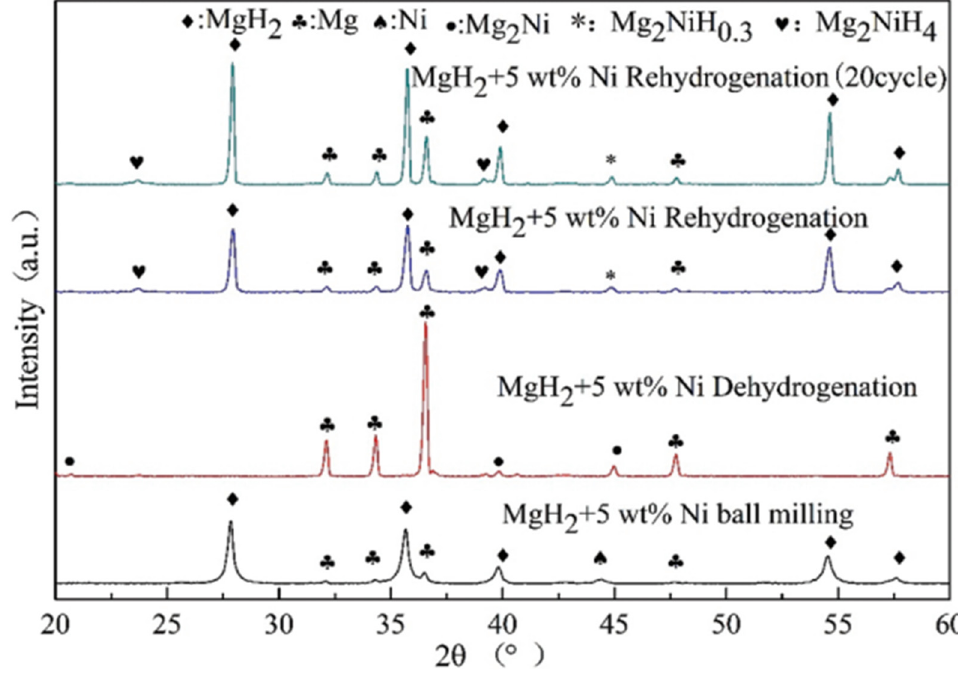
Figure 3. XRD patterns after ball milling, the hydrogen dehydrogenation, rehydrogenation and after the 20th cycle for MgH 2 + 5 wt.% Ni. Copyright 2021, The Royal Society of Chemistry. Reproduced with permission from [64].